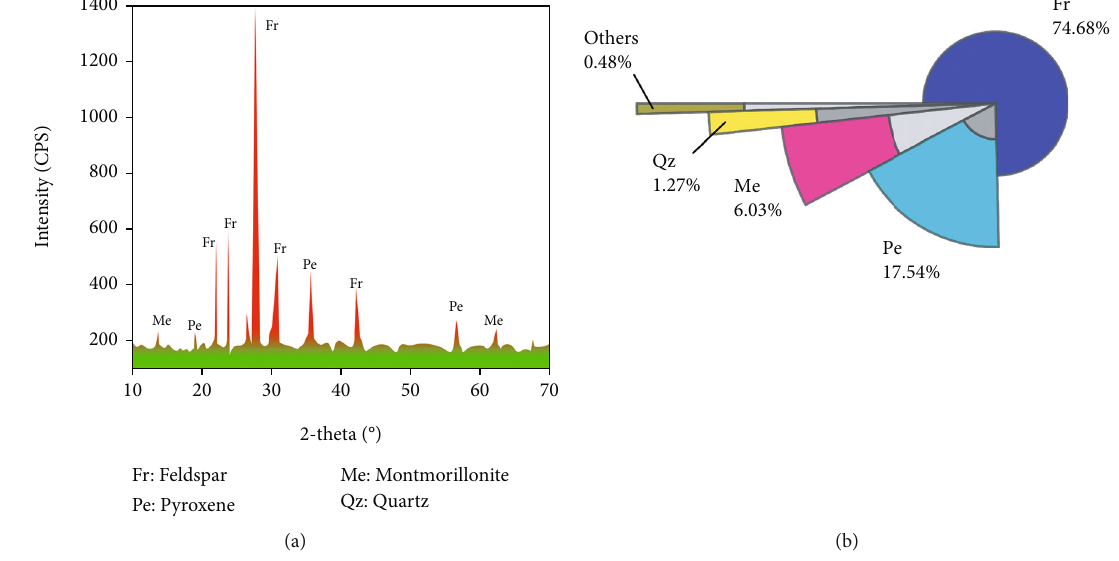
Figure 2: XRD test of the basalts: (a) mineralogic composition and (b) proportion of the minerals. Table 1: Physical properties of the testing basalt